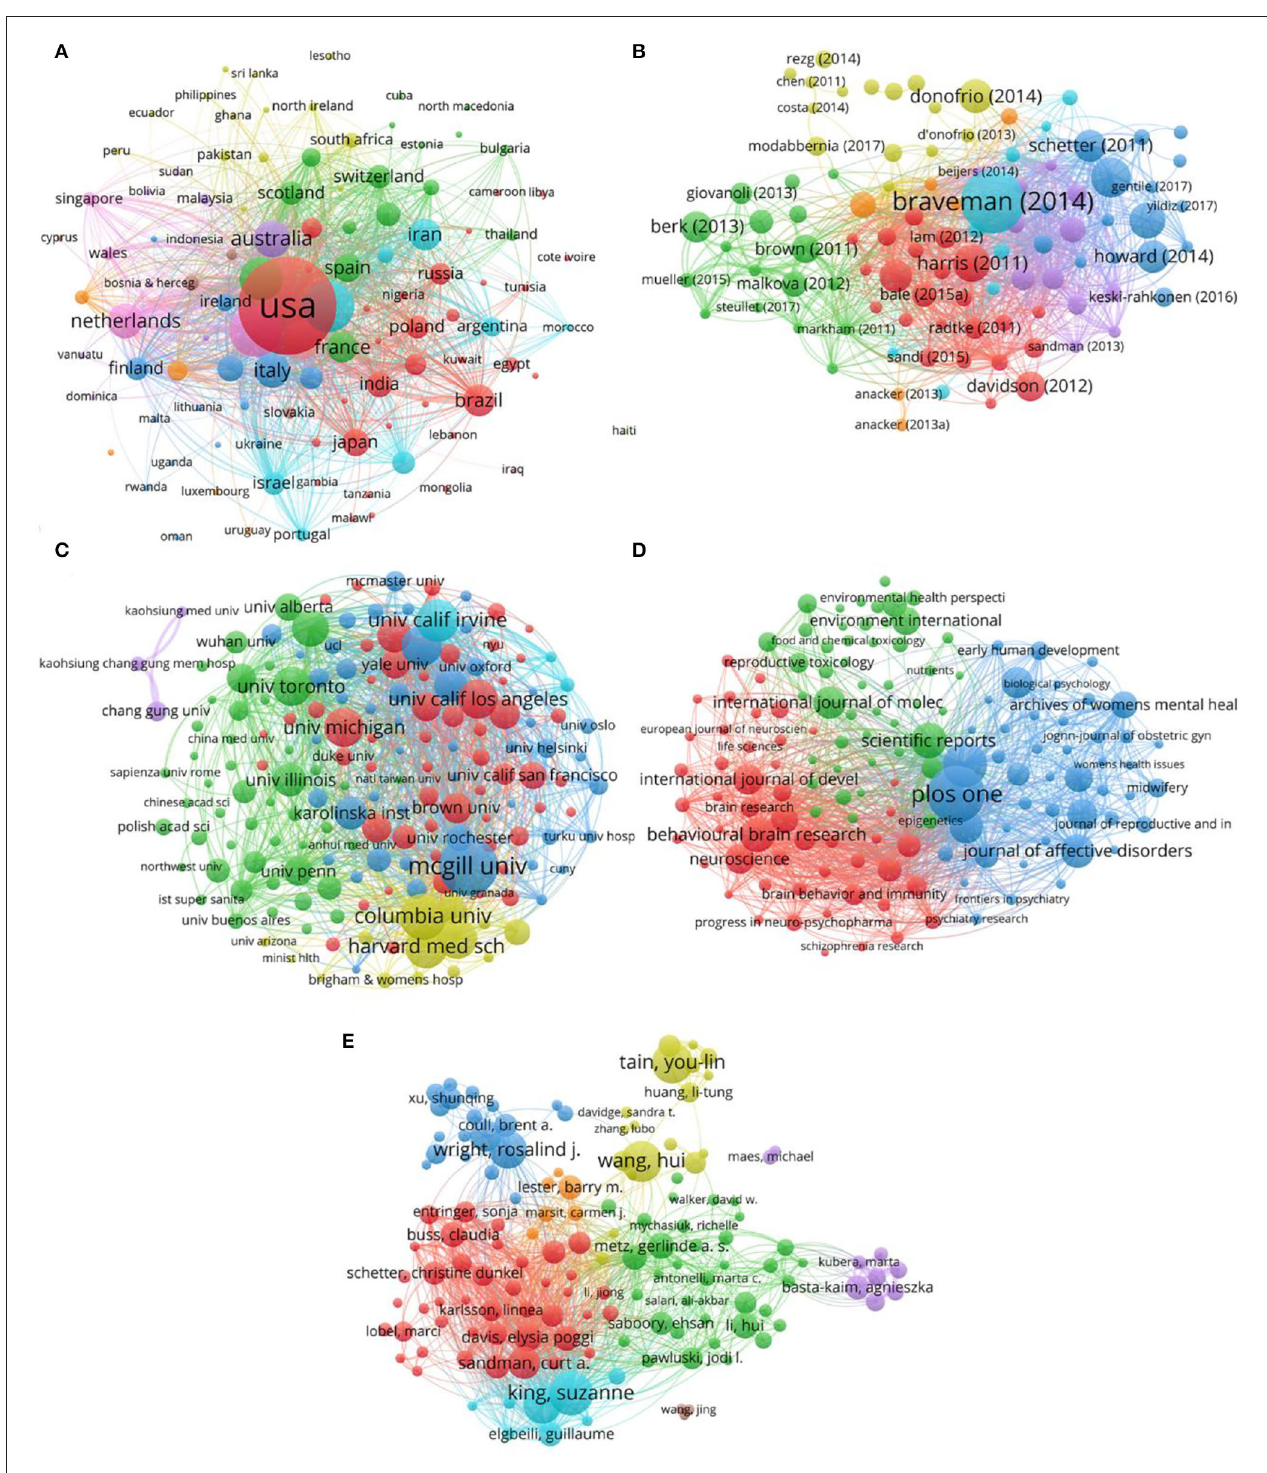
FIGURE 10 | Bibliographic coupling analysis of PS-related research. (A) Network of bibliographic coupling countries. (B) Network of bibliographic coupling documents. (C) Network of bibliographic coupling affiliations. (D) Network of bibliographic coupling journals. (E) Network of bibliographic coupling authors.